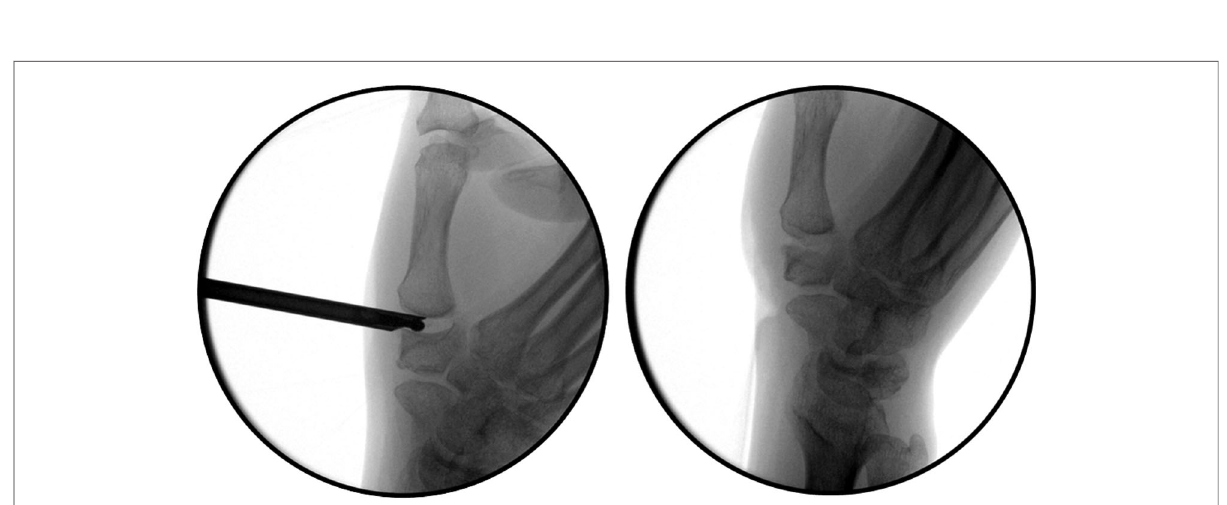
FIGURE 2 Arthroscopy-assisted partial trapezium resection. (Left): Partial trapeziectomy is performed with the 1.9 mm burr. (Right): The articular surface of the part of the trapezium is removed until it shows hemispherical fossa.